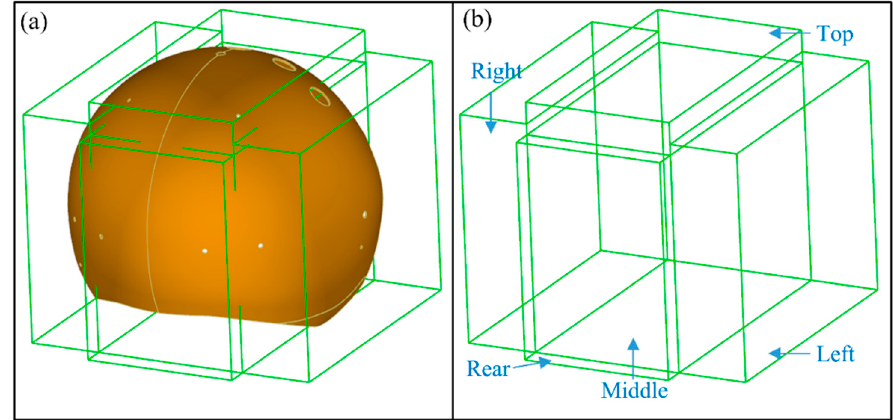
Figure 10. Division of the helmet: ( a ) Dividing the helmet into five areas; ( b ) Names of five areas.